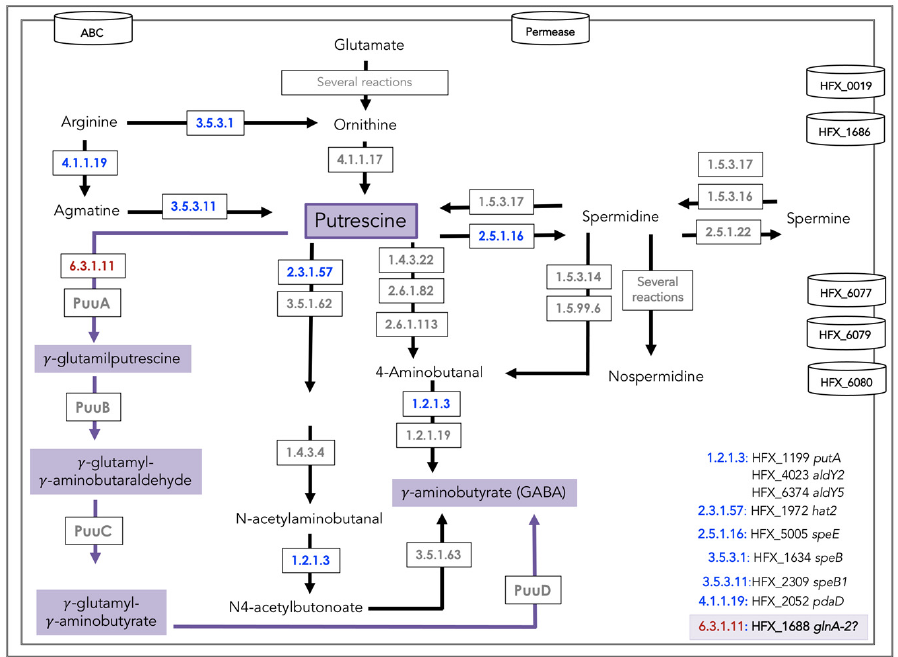
Figure 8. Representation of the possible metabolic pathways of putrescine degradation and other polyamines in Hfx. mediterranei R4. Image based on the metabolic maps included in the KEGG database (organism code: hme). In blue, the EC numbers of each of the enzymes whose coding genes are present in Hfx. mediterranei are indicated. In grey, the enzymes that catalyze these reactions whose genes are not present in the genome of this halophilic archaea. In red, the two genes that could encode glutamate–putrescine ligase. The white cylinder represents the different amino acid and polyamine transporters.